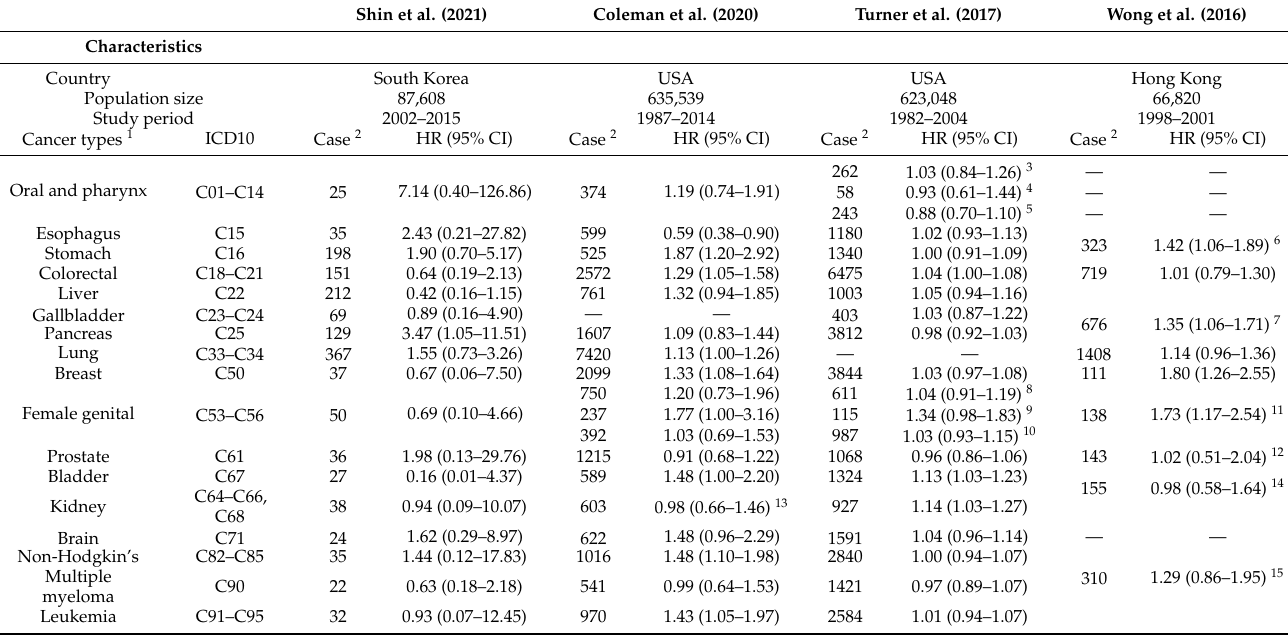
Table 3. Findings of the present study and three previous studies that compared the associations of PM 2.5 and cancer mortality across different cancer